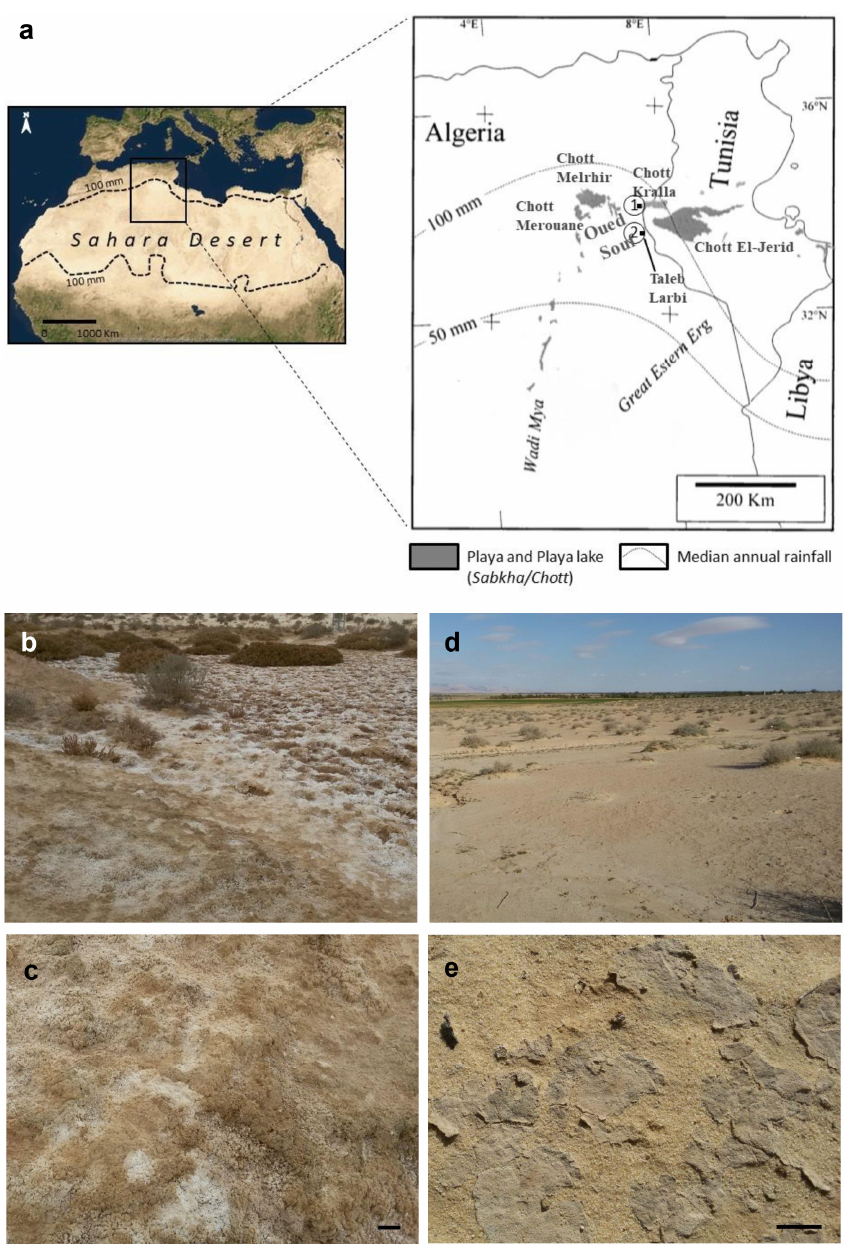
Figure 1. ( a ) Location of the studied area and sampling sites. 1. Chott Kralla, 2. Taleb Larbi. ( b ) General view of Chott Kralla. ( c ) Biocrust from Chott Kralla. ( d ) General view of Taleb Larbi. ( e ) Biocrust from Taleb Larbi. Scale bar 2 cm.